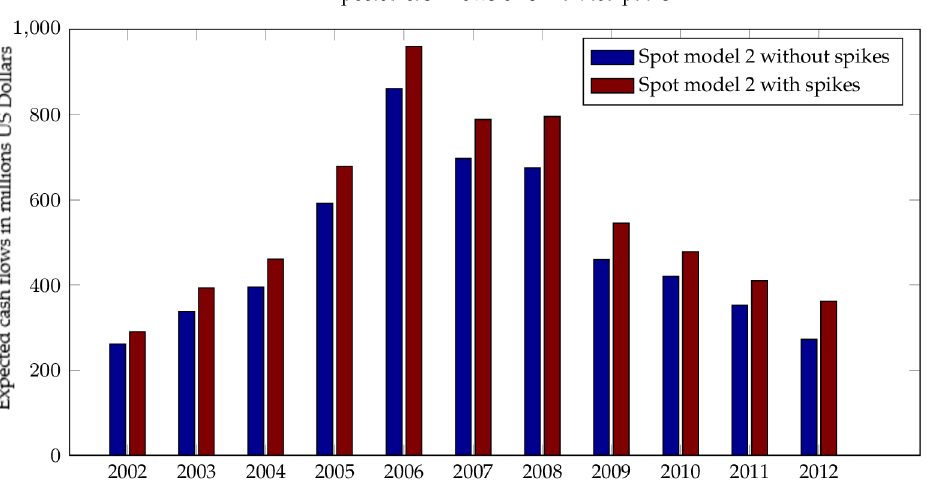
Figure 10. Expected cash flows on simulated paths.